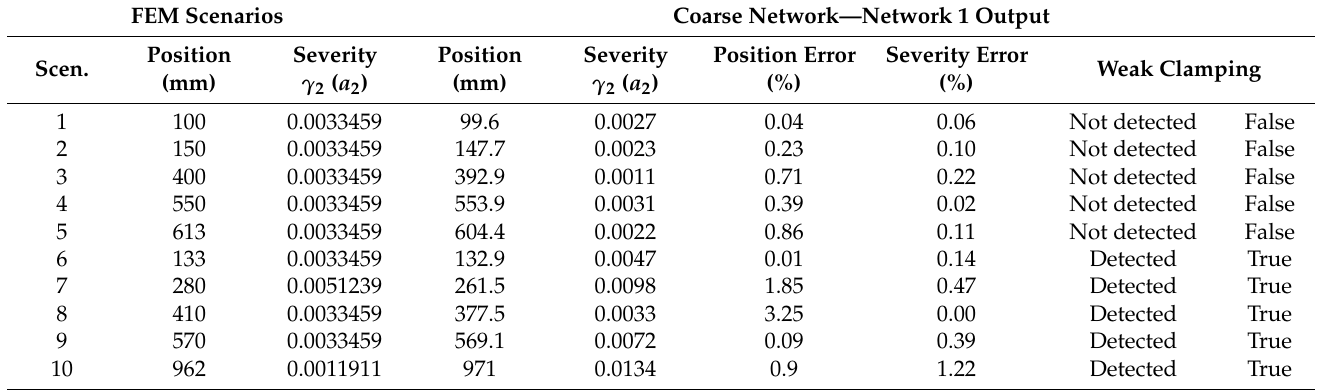
Table 7. Results obtained using network 1 —coarse estimation.